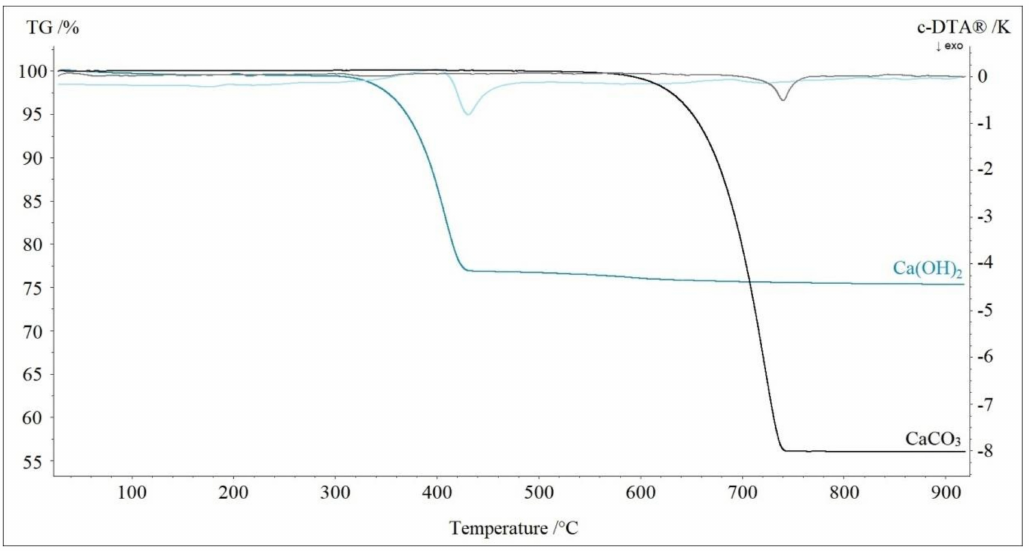
Figure 2. TG-DTA curves of decomposition of calcium hydroxide and calcium carbonate in